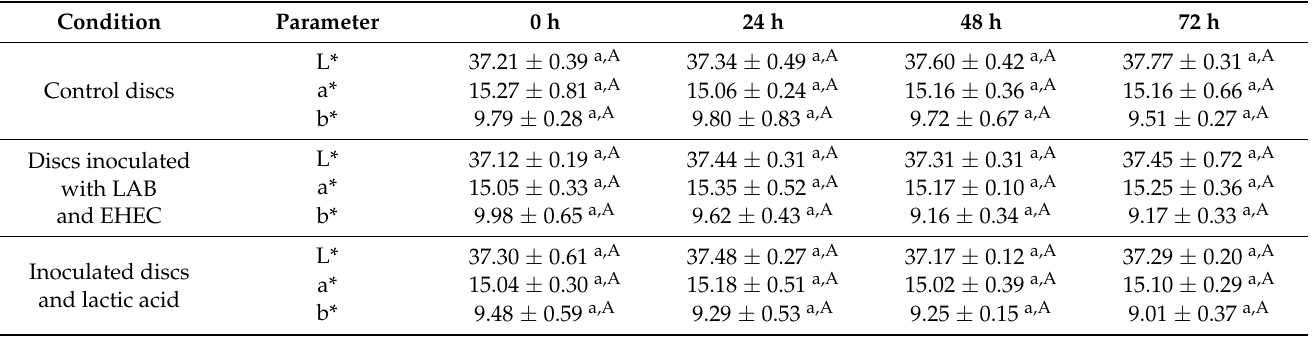
Table 3. CIE Lab parameters in meat discs at the different assayed conditions during 72 h of incubation at 8 ◦